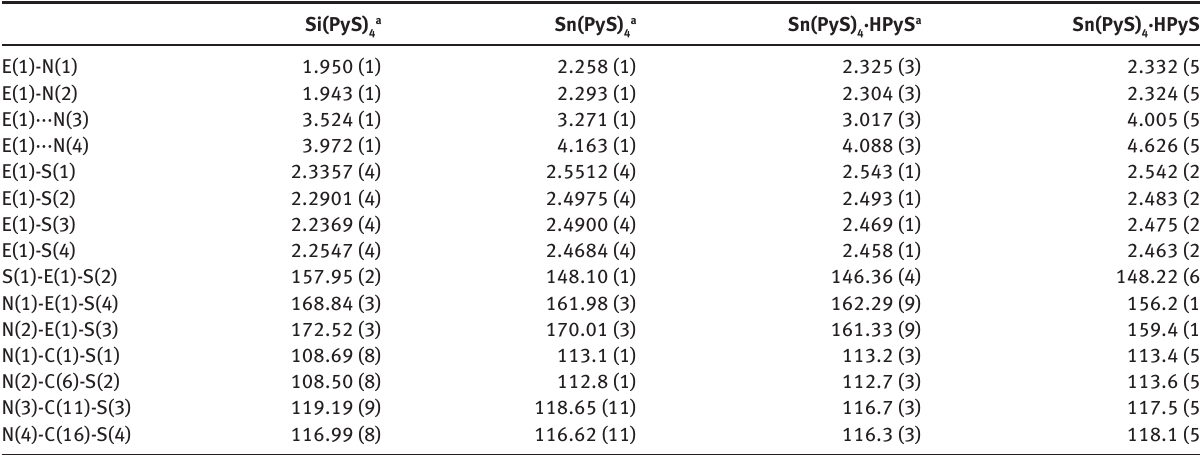
molecules of two different crystal structures of Sn(PyS) 4